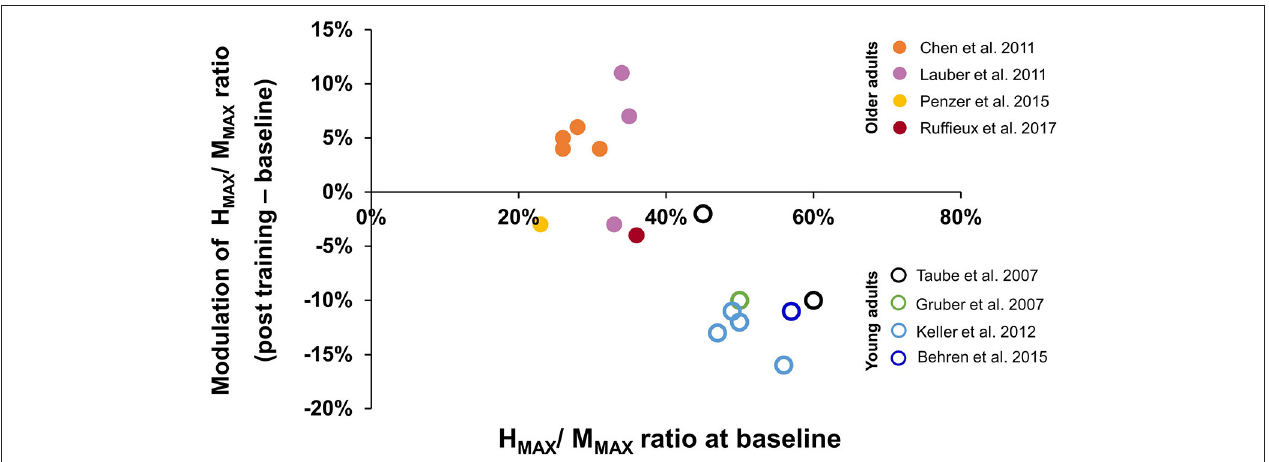
FIGURE 2 | Modulation of H MAX /M MAX ratio after balance training. The x-axis represents averaged H MAX /M MAX ratio at baseline, the y-axis represents the modulation of H MAX /M MAX ratio after balance training, with negative values indicating reduced H MAX /M MAX ratio after training. Data were obtained from 8 studies (see Results, Section 3.5). Data from different test conditions within the same study are represented by the same color. The solid dots represent data from older adults, while the open circles represent data from young